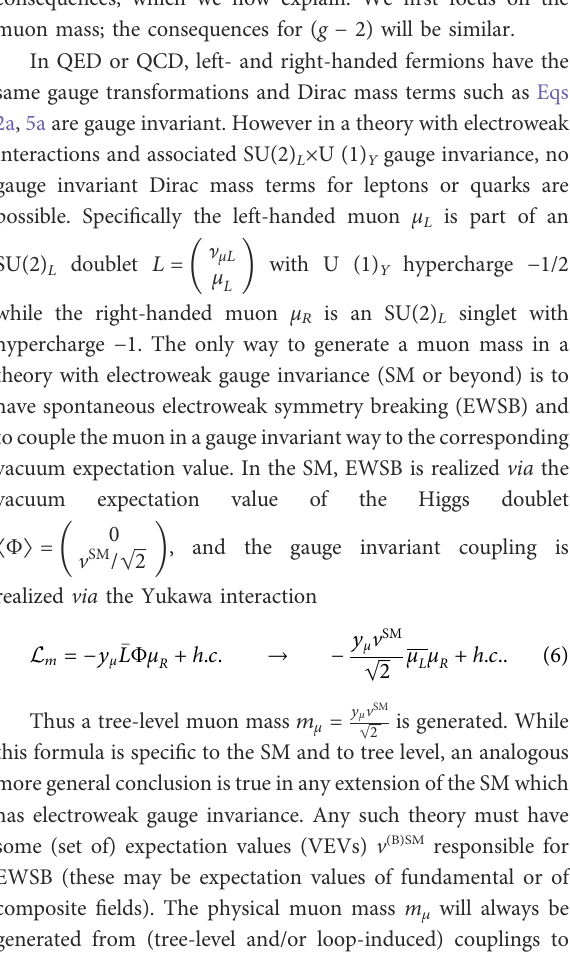
FIGURE 1 One-loop Feynman diagram illustrating Eqs 10, 11. Each contribution to the muon mass and to a μ must involve one factor of some SM or BSM VEV breaking electroweak symmetry, illustrated by v (B) SM , and a chirality fl ip between μ L and μ R . In order to obtain a contribution to a μ , a photon needs to couple to anyofthechargedinternallines. S and F denote genericscalar and fermionic